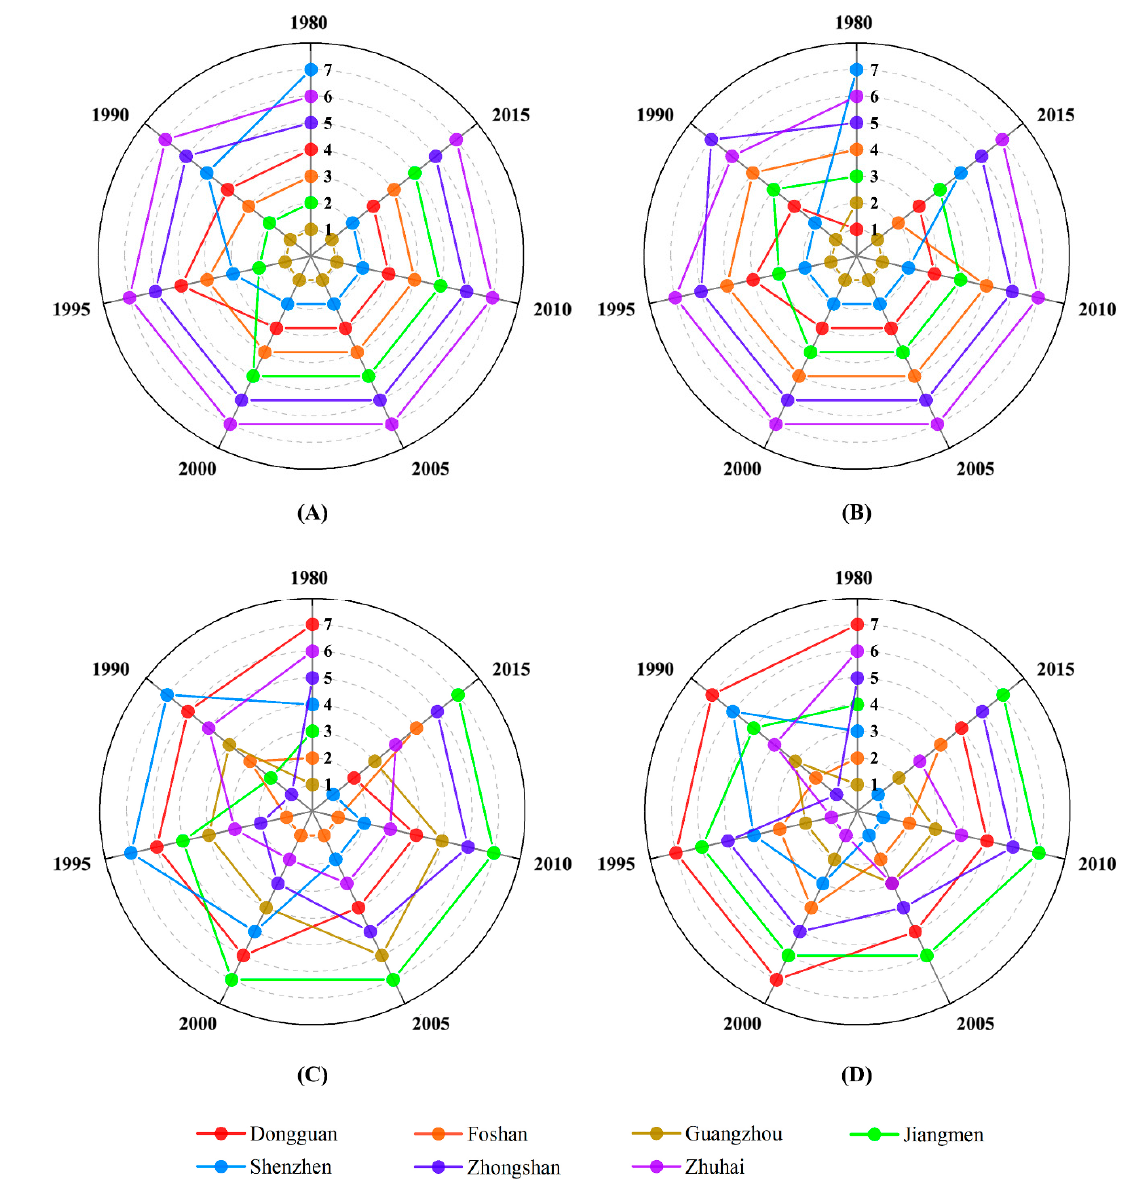
Figure 6. The temporal evolution of rankings for seven cities from 1980 to 2015, in terms of four indicators: ( A ) population, ( B ) urban land area, ( C ) population per unit urban land area, ( D ) regional GDP per unit urban land area.